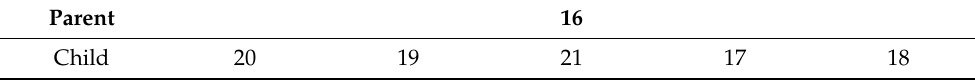
Table 4. Sorting of parent in decreasing order of children at level